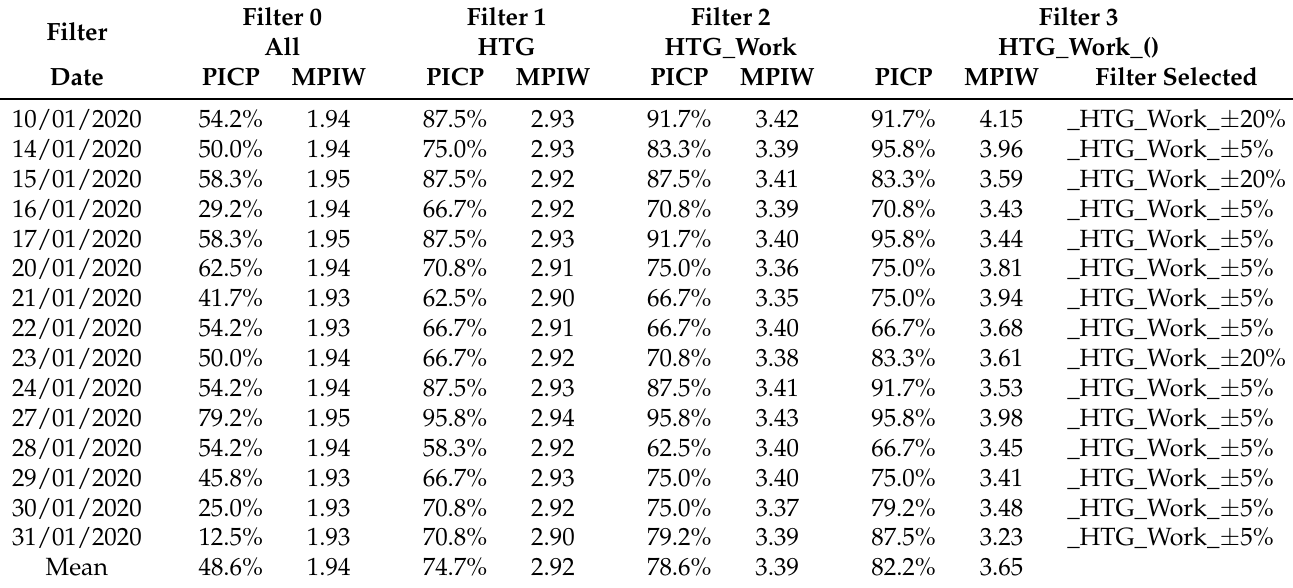
Table 6. PICP and MPIW results for the validation period for the four